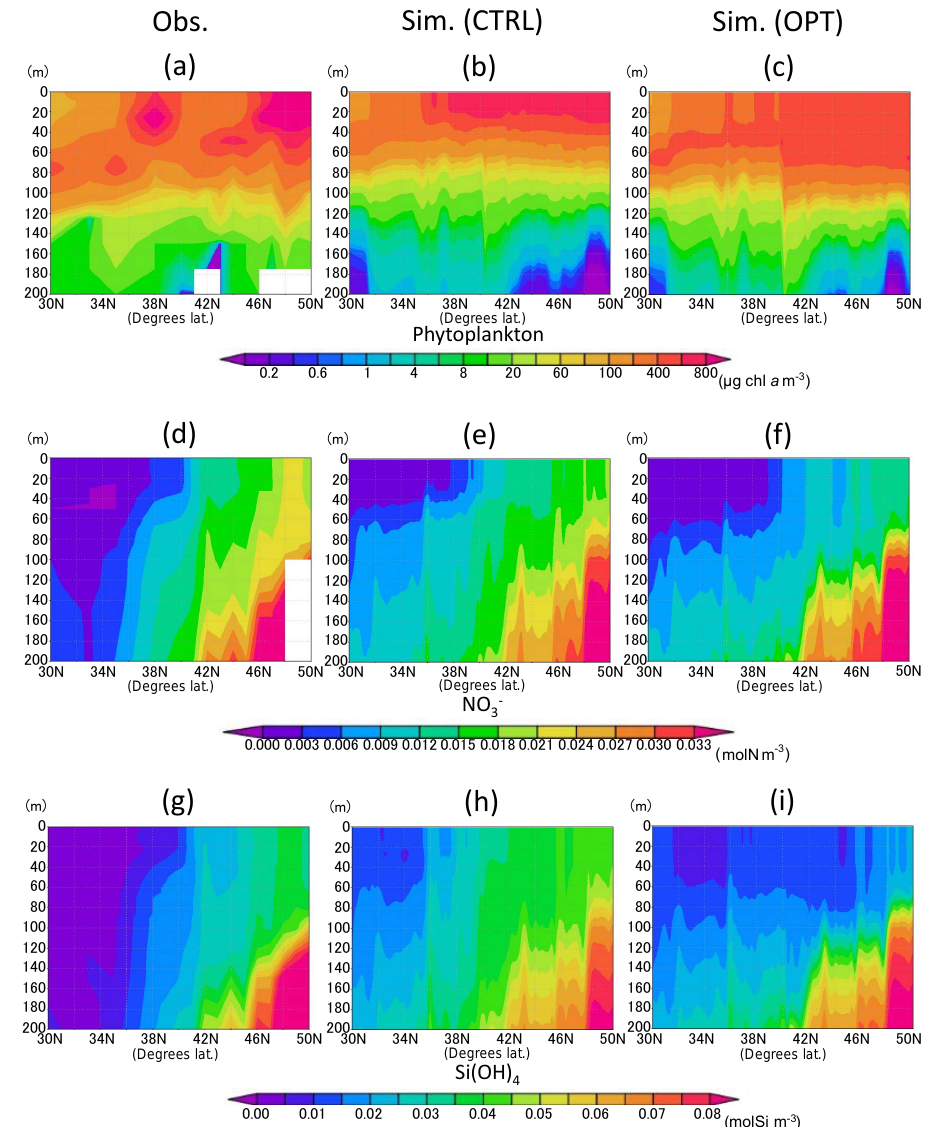
Figure 6. Vertical distribution of phytoplankton (a–c) , nitrate (d–f) , and silicate (g–i) along the 165 ◦ E section in June 1998. (a, d, g) Data in situ observed during 16 to 21 June 1998 downloaded from the World Ocean Database 2013. (b, e, h) Simulation result of the control case mean in June 1998. (c, f, i) Simulation result of the parameter-optimized case mean in June 1998. Areas of missing values are left